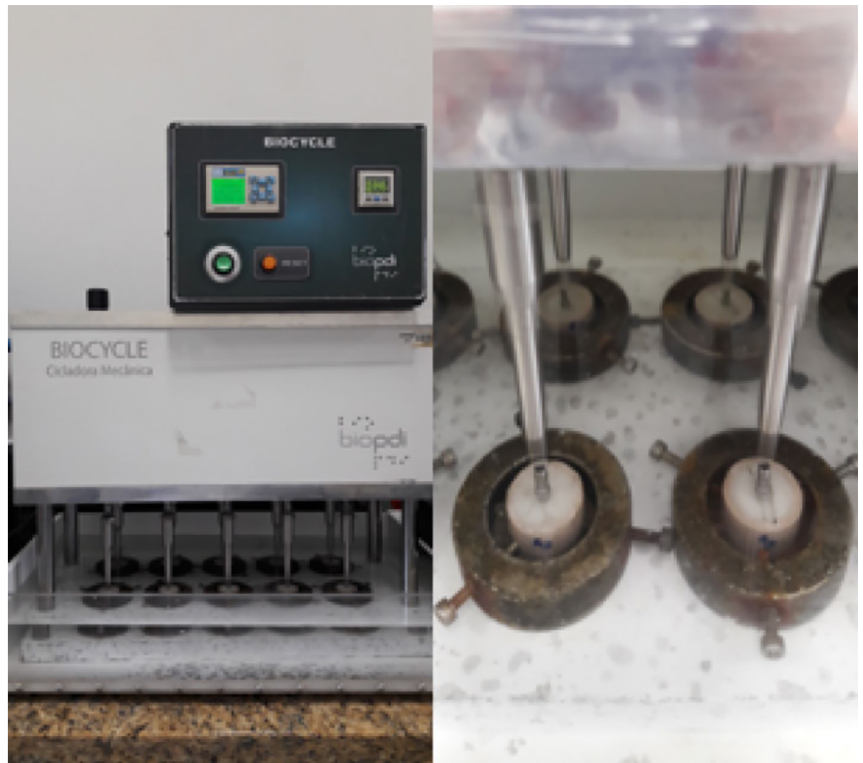
Figure 3. Representation of mechanical cycling in IIAMC.